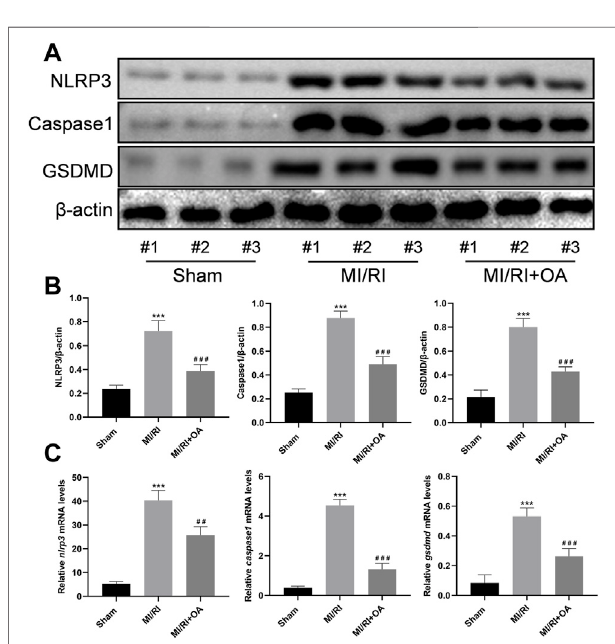
FIGURE 7 | OA treatment ameliorates MI/RI induced pyroptosis in vivo (A,B) WB and quantitative analysis for NLRP3, Caspase1, and GSDMD expression levels in the heart tissues (C) RT-qPCR data showing that the transcripts levels for nlrp3 , caspase1 , and gsdmd in the heart tissues. Data are presented as the mean ± SD. p p < 0.001, compared with the Sham group; # p < 0.001, compared with the MI/RI group. MI/RI: myocardial ischemia/reperfusion injury; WB: Western Blot; RT-qPCR: reverse-transcription quantitative PCR; OA: Oroxin A.